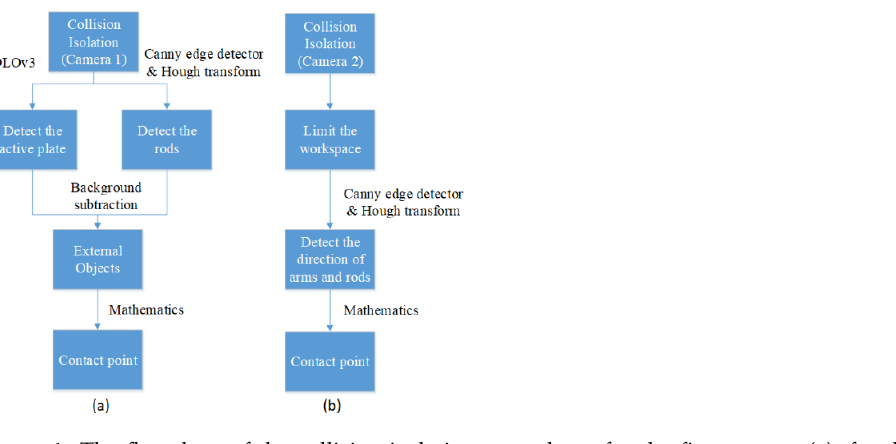
Figure 4. The flowchart of the collision isolation procedure: for the first camera ( a ); for the second camera ( b ).